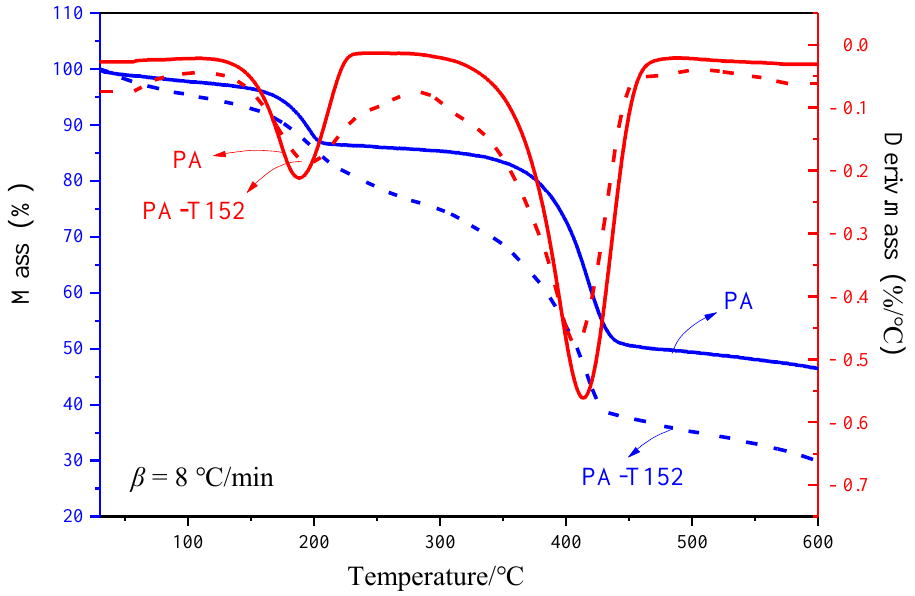
Figure 5. DTG curves of PA and PA-T152 at different β . Table 1. Thermogravimetric loss data for PA and PA-T152.